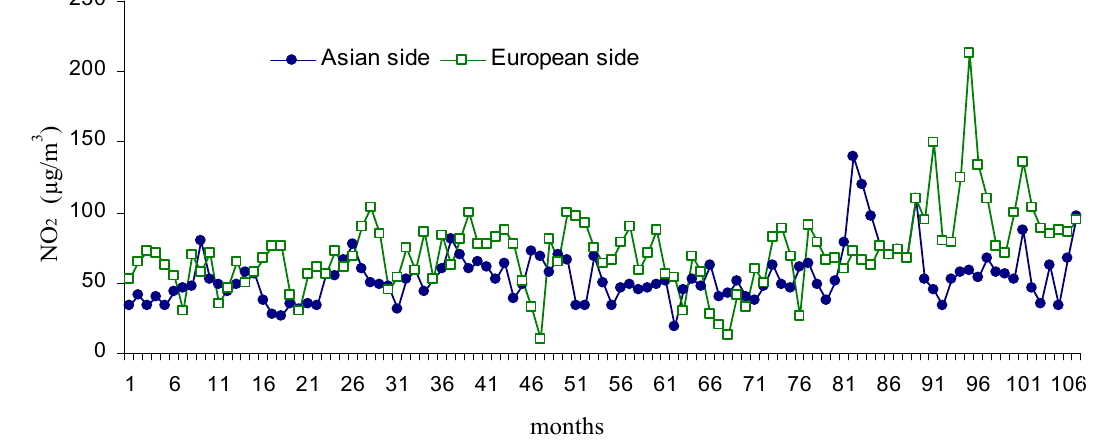
(µg/m 3 ) during the study period (Jan 2002–Dec 2010). 2